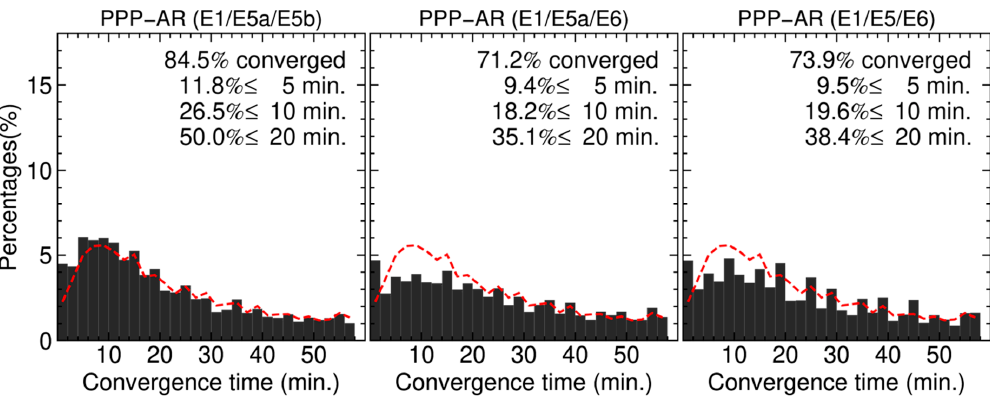
Figure 6. Statistics of the convergence time (minutes) of 15 stations’ triple-frequency (E1 / E5a / E5b, E1 / E5a / E6, and E1 / E5 / E6) PPP-AR with the o ffi cial GPS receiver antenna corrections. The percentage of the convergence and the percentages of the convergence time lengths shorter than 5, 10, and 20 min are shown in each subfigure. The red dashed lines represent the percentage distributions of the convergence time of dual-frequency (E1/E5a) PPP-AR.